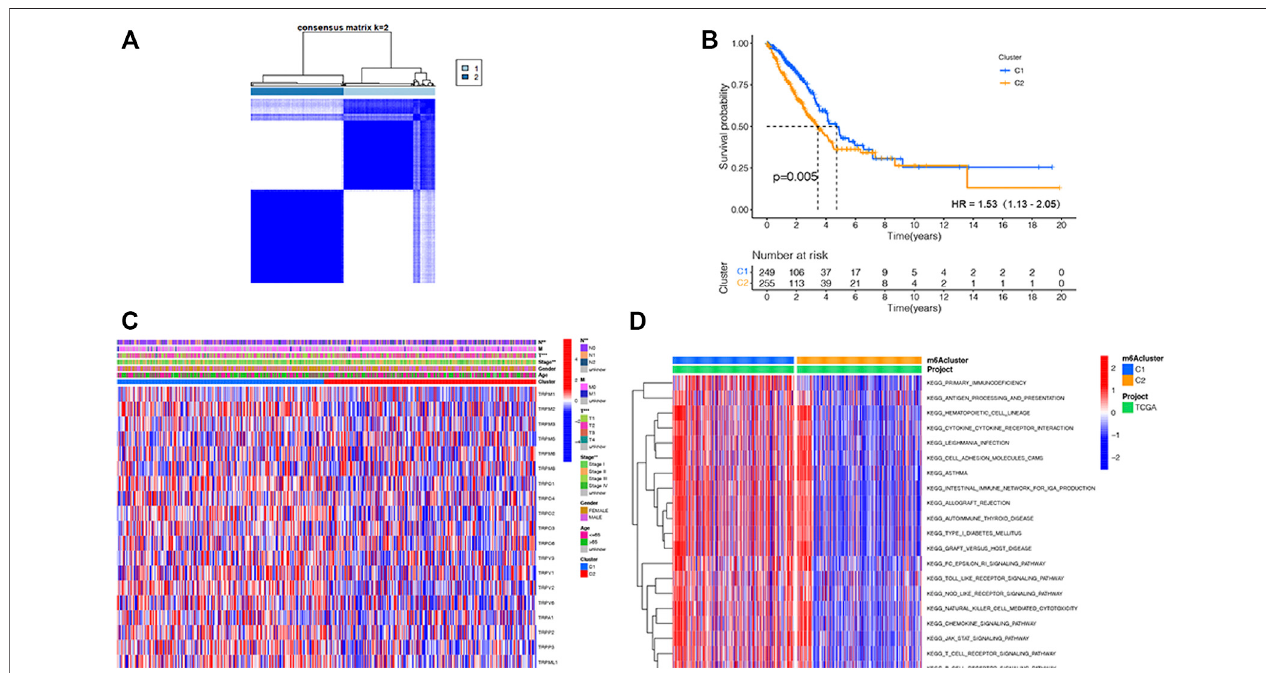
FIGURE 2 | TRP-related subtypes and their clinicopathological features and biological pathways. (A) . Consensus matrix heatmap identifying two subtypes ( κ = 2). (B) .Kaplan – MeierOScurvesofthetwosubtypes. (C) .Variationsinclinicopathologiccharacteristics andTRPgeneexpressionlevelsbetweenthetwodistinctsubtypes. (D) . Biological pathways to two distinct subtypes via GSVA (red: activated pathways; blue: inhibited